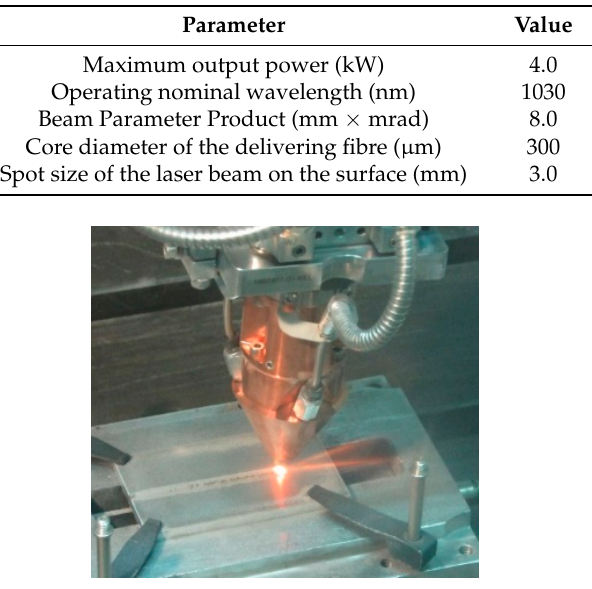
Figure 2. Laser head performing direct metal deposition.